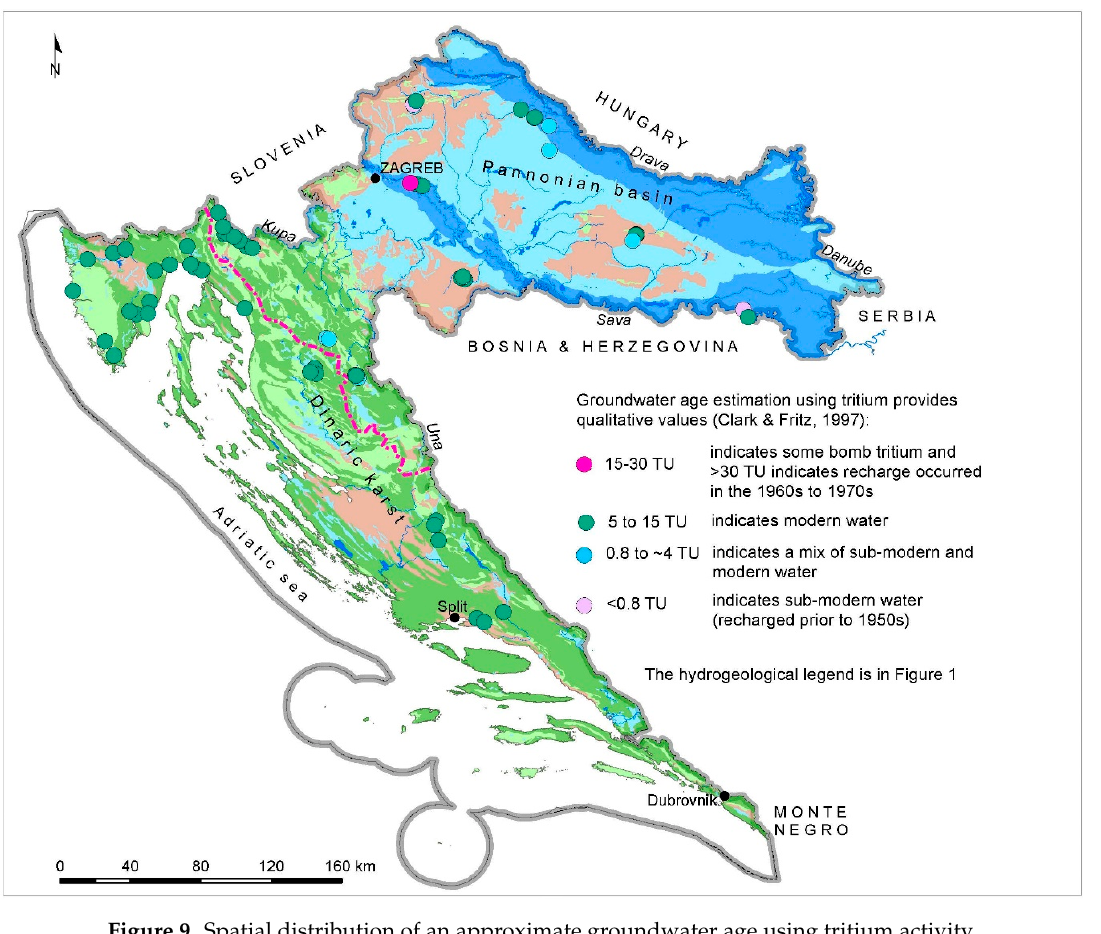
Figure 9. Spatial distribution of an approximate groundwater age using tritium activity. 501